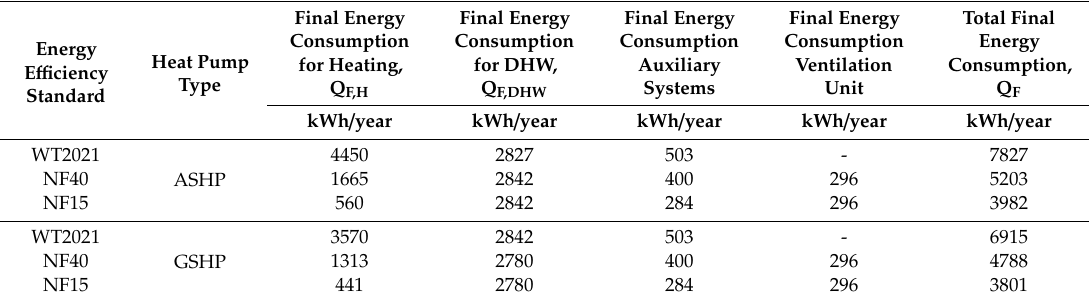
Table 11. Final energy consumption for heating, DHW and auxiliary systems for the WT2021, NF40 and NF15 standards.